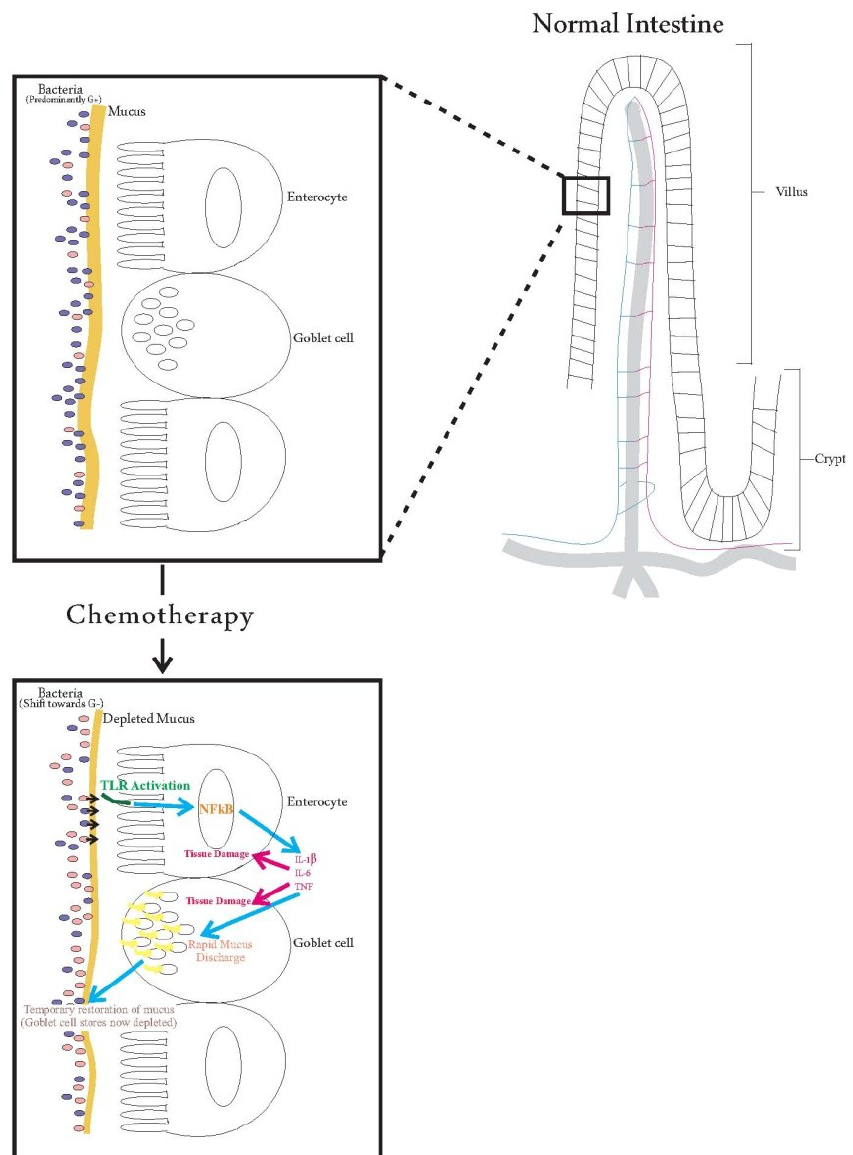
Figure 1. Relationships between mucins, microbiota and cytokines: the effects of